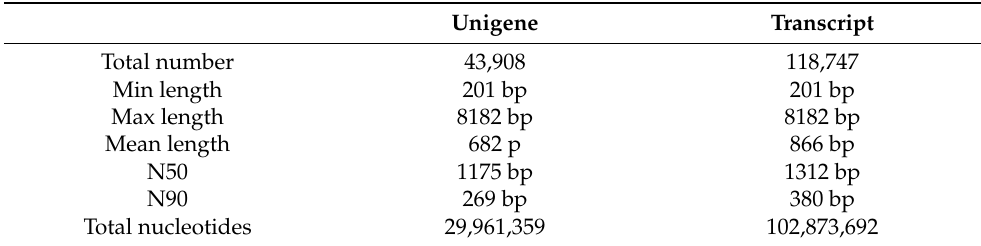
Table 4. Summary of RNA-sequencing and de novo assembly.